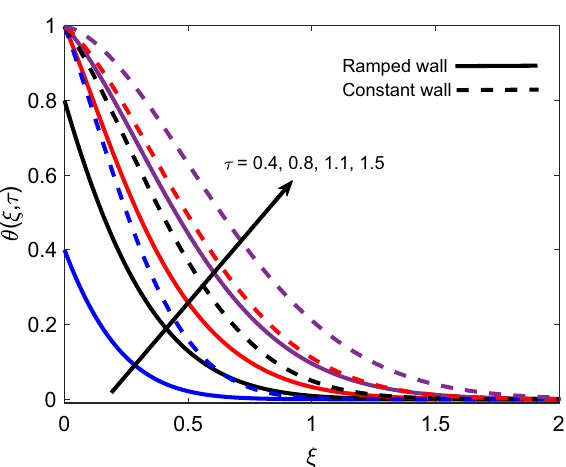
Figure 7. Energy distribution for various values of τ